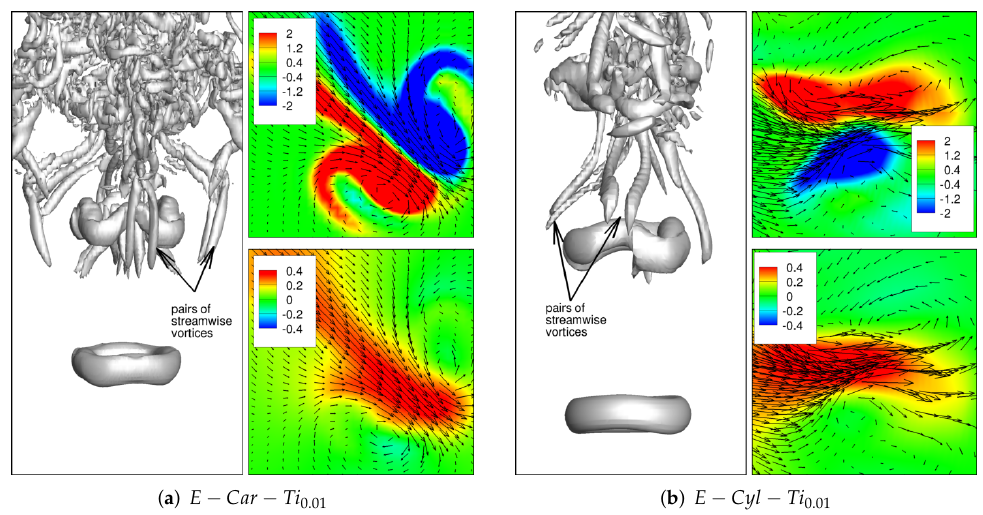
Figure 8. Iso-surfaces of Q -parameter Q = 1 ( U 0 / D ) 2 ( a , b left ) and contours of streamwise vorticity ω x × D / U 0 ( a , b right top ) and radial velocity U r / U 0 ( a , b right bottom ) with velocity